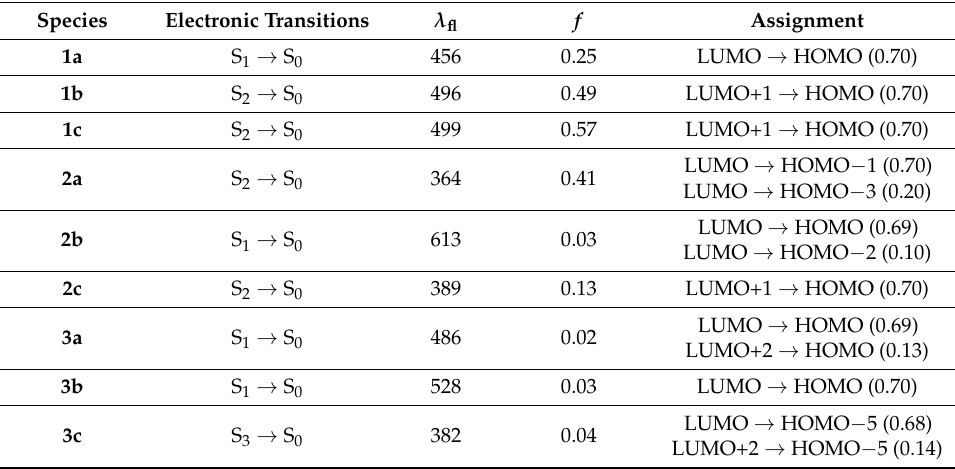
Table 3. The strongest fluorescence wavelengths λ fl , the oscillator strength f , and main assignments (coefficient) of the designed molecules at the TD-PBE0/6-31G(d,p)//TD-PBE0/6-31(d,p) level.